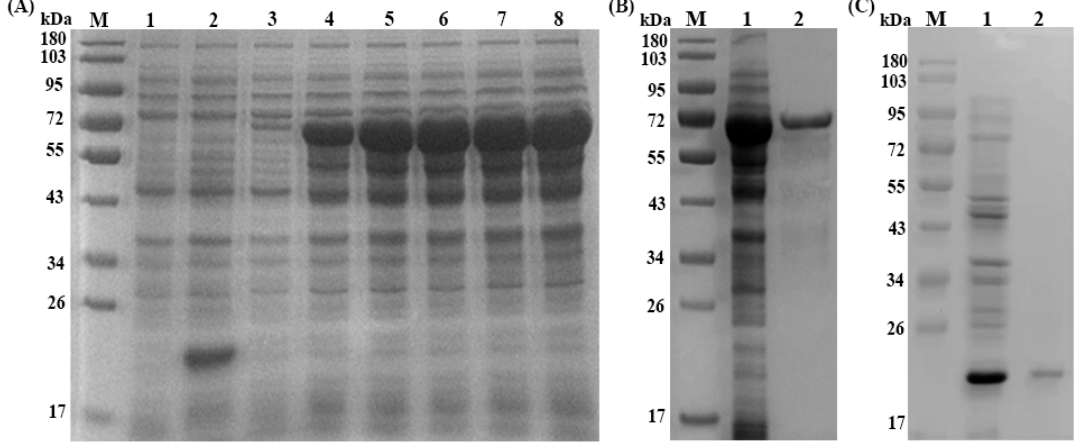
Figure 1. Expression and purification of rTs-SUCLA- β . Lane M: standard protein molecular weight